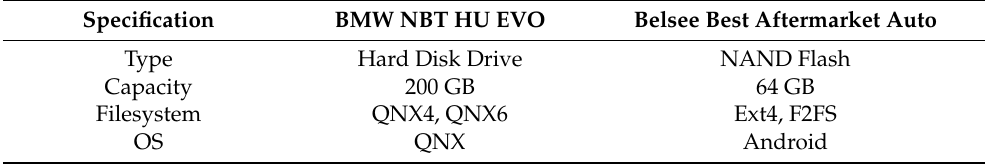
Figure 8. BT paired device list ( bt_conf.ini) and phone number acquired from Belsee Best After- market Auto (DateBase1. db ). Table 8. List of Artifacts in IVI System Internal Storage. IVI System Artifact